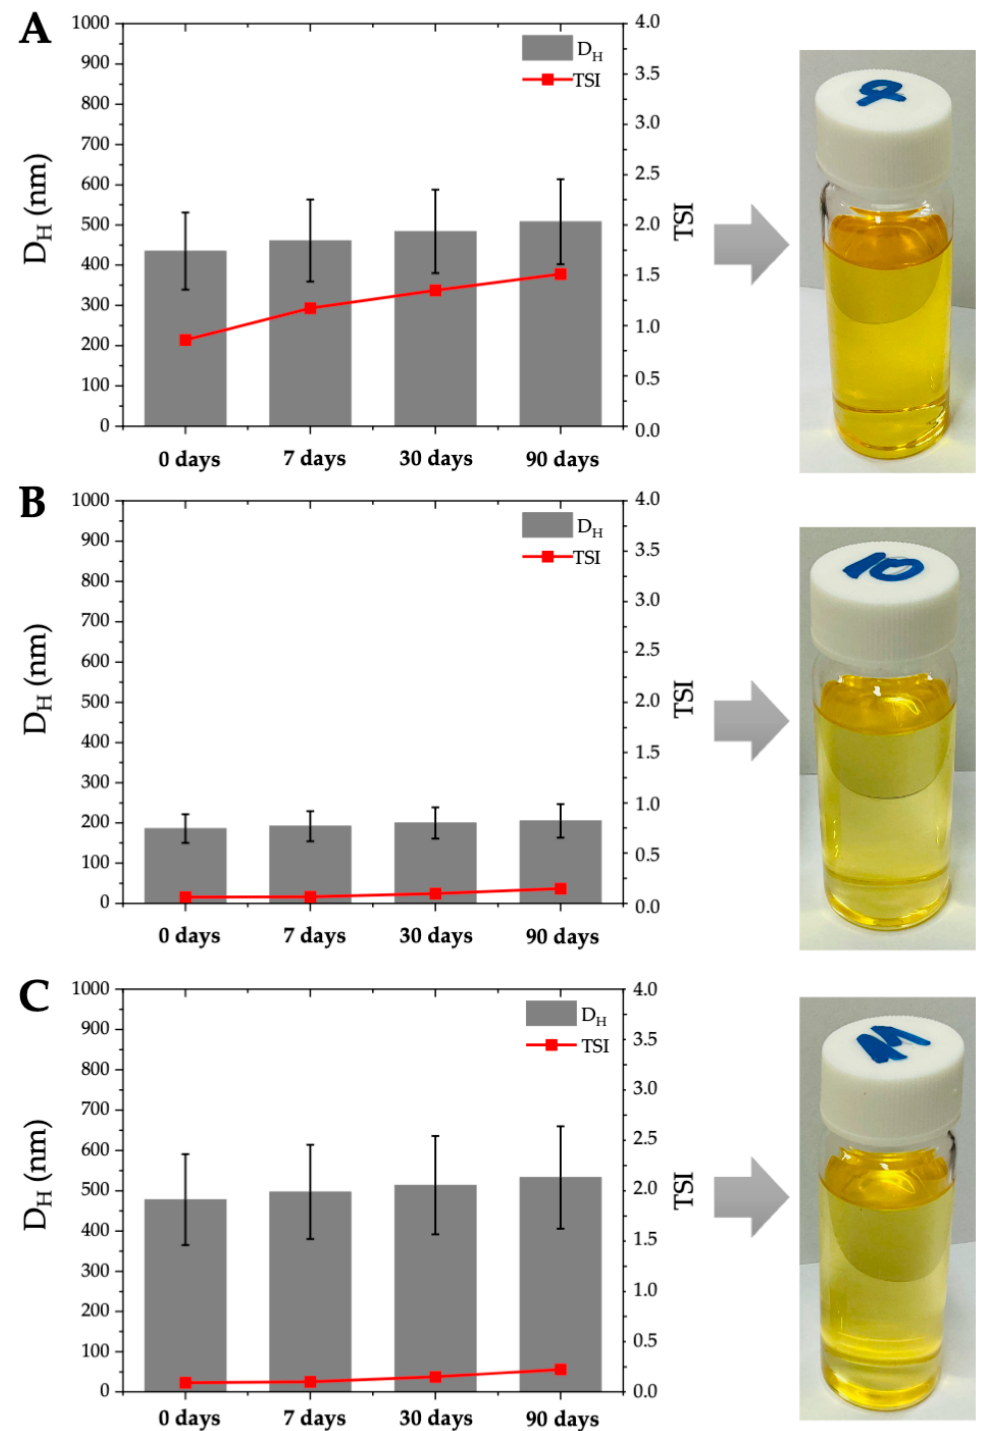
Figure 1. Changes in the key parameters (DH and TSI) to characterize the stability of nanoemulsions during the 3-month storage period. ( A ) NE No. 7. ( B ) NE No. 10. ( C ) NE No. 11.